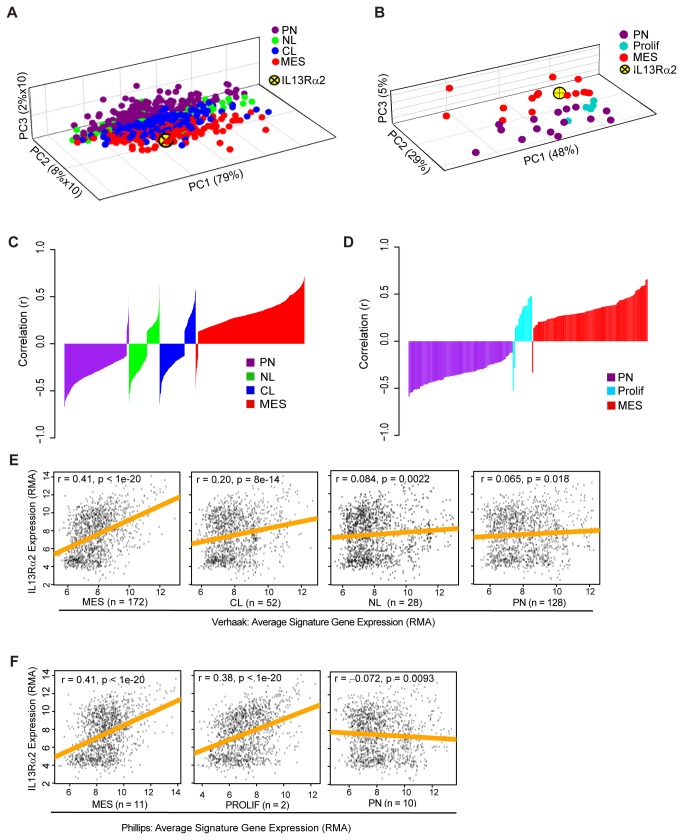
IL13Rα2 expression is associated with mesenchymal signature gene expression in gliomas.(A, B) Principal Component Analysis (PCA) plots of signature genes with respect to IL13Rα2 for glioma subclasses defined by (A) Verhaak et al. [5] (proneural (PN), neural (NL), classical (CL) and mesenchymal (MES)) and (B) Phillips et al. [6] (proneural (PN), proliferative (PROLIF) and mesenchymal (MES). Each point represents the position of one signature gene. (C, D) Silhouette plots of Pearson correlation coefficients for all significant correlations (FDR < 0.05) between IL13Rα2 and probes for genes defining glioma subtypes as defined by (C) Verhaak et al. [5], and (D) Phillips et al. [6] . Correlations are sorted based upon GBM subtype and then ordered by increasing correlation coefficient values. (E-F) Scatter plots for IL13Rα2 expression versus the average expression of (E) TCGA mesenchymal (MES), proneural (PN), classical (CL) and neural (NL) genes, and (F) the average expression of Phillips mesenchymal (MES), proliferative (PROLIF), and proneural (PN) genes). Linear regression of IL13Rα2 expression as a function of gene expression is shown by the orange lines. Number of signature genes (n) used to calculate average signature gene expression is reported for each plot (Methods and Datasets S3 and S4 in File S2).